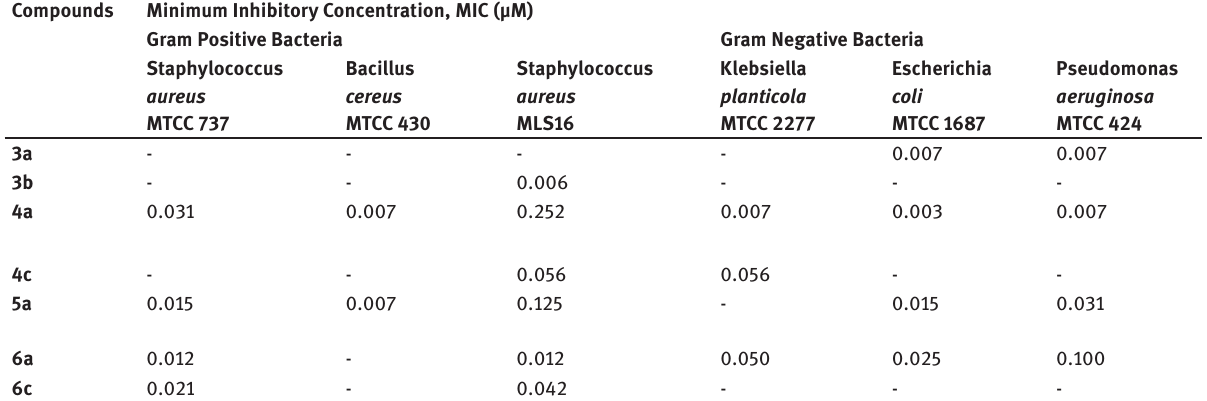
Table 3: Antibacterial activity of compounds by micro dilution method.